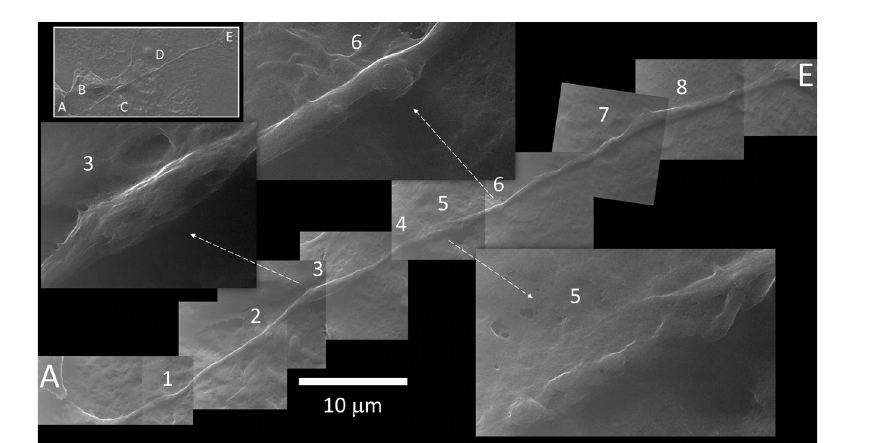
Figure 3. Tunneling nanotube. The long TNT that connects cell A to B (named 1 and 2 in Fig. 2) interacts with at least three other cells along its path (B, C and D, in the top left inset). A mosaic reconstruction of HeIM micrographs (27,000×) highlights 8 notable events, some of which are magnified at a higher definition (×54,000). (1) Spherical bulging; (2) well defined spherical bulging and membrane fusion, in a region rich in mitochondria; (3) diameter enlargement by cargo content; (4) spherical bulging close to a (5) membrane fusion area; (6) well defined spherical bulging; (7) two close spherical bulging; (8) diameter enlargement. Higher definition micrographs show longitudinal cytoskeletal features under the